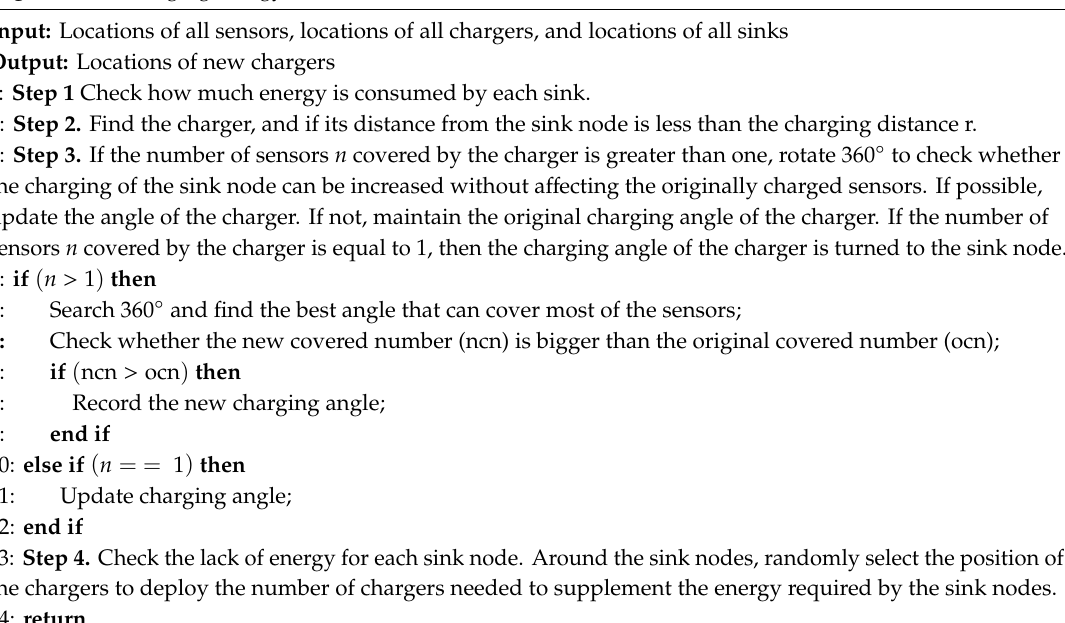
Algorithm 3 Charging energy of the sink